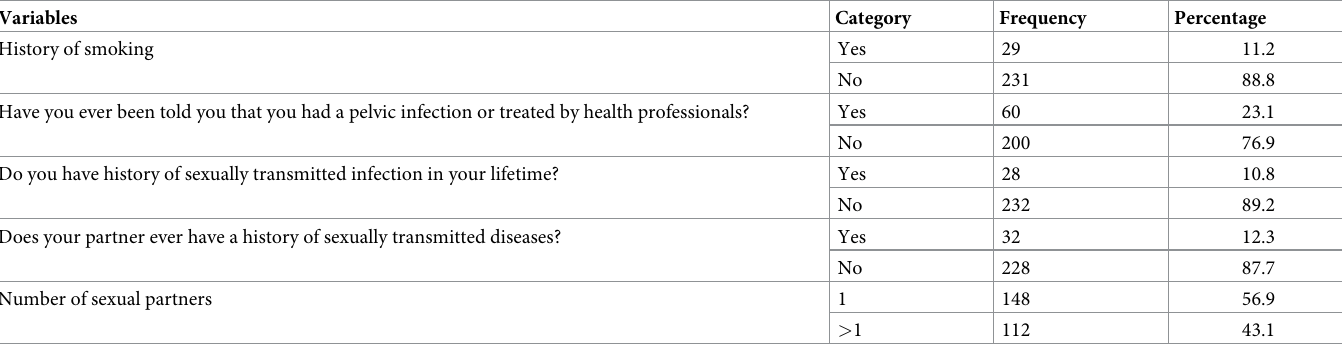
Table 5. Lifestyle and sexually related characteristics of respondents among reproductive age group women in districts of Gurage Zone, Southern Ethiopia, 2019.